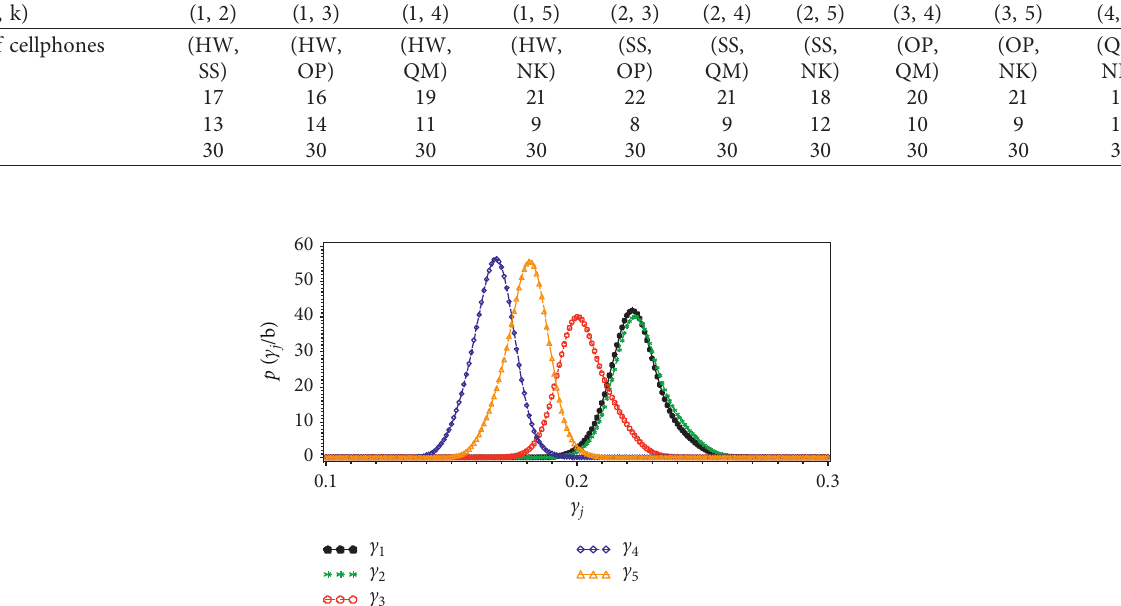
Figure 1: The marginal posterior distributions using uniform prior.